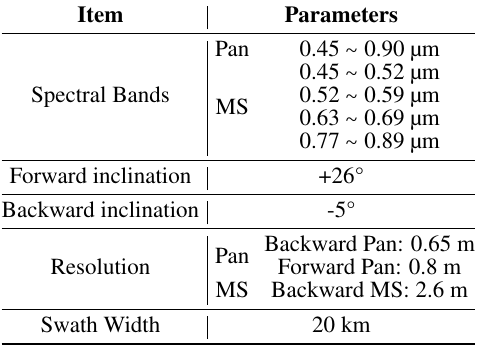
Table 1. Description of GF-7 two-line stereo imagery (GF-7 Satellite,